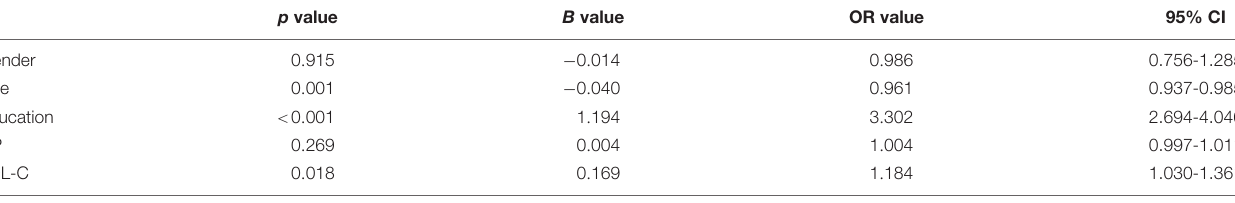
TABLE 2 | Binary logistic regression of gender, age, education, blood pressure and low-density lipoprotein cholesterol on cognitive impairment, China, 2016.